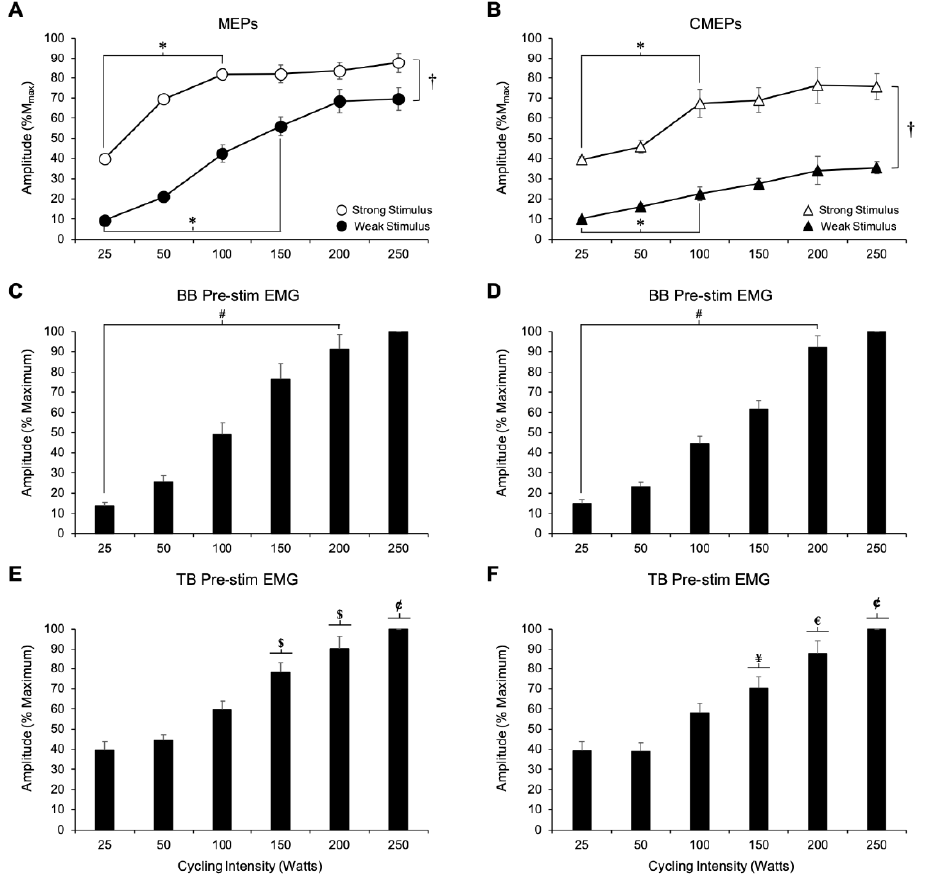
Figure 3. ( A , B ) Normalized grouped data (means ± SE) of the peak-to-peak amplitudes for MEPs ( A ) and CMEPs ( B ) obtained from the biceps brachii at each power output examined. MEPs and CMEPs were normalized to M max at each corresponding cycling intensity. In both A and B, filled data points represent when the weak stimulus was used, while unfilled points represent data from the strong stimulus. For clarity, circles were used for MEPs, while triangles were used for CMEPs. In some cases, data points are bigger than SE bars. * Significant di ff erence between illustrated data points. † Significant main e ff ect for stimulation strength ( p < 0.05). ( C , D ) Pre-stimulus EMG (means ± SE) from the biceps brachii which has been pooled and averaged between both stimulation intensities for the TMS session ( C ) and TMES session ( D ), respectively. # Significant di ff erence between all data points. ( E , F ) Pre-stimulus EMG (means ± SE) from the triceps brachii which has been pooled and averaged between both stimulation intensities for the TMS session ( E ) and TMES session ( F ), respectively. $ denotes significant di ff erence from all previous power outputs. ¥ denotes significant di ff erence from the 25 W condition. € denotes significant di ff erence from the 25, 50, and 100 W conditions. ¢ denotes significant di ff erence from the 25, 50, 100, and 150 W conditions.